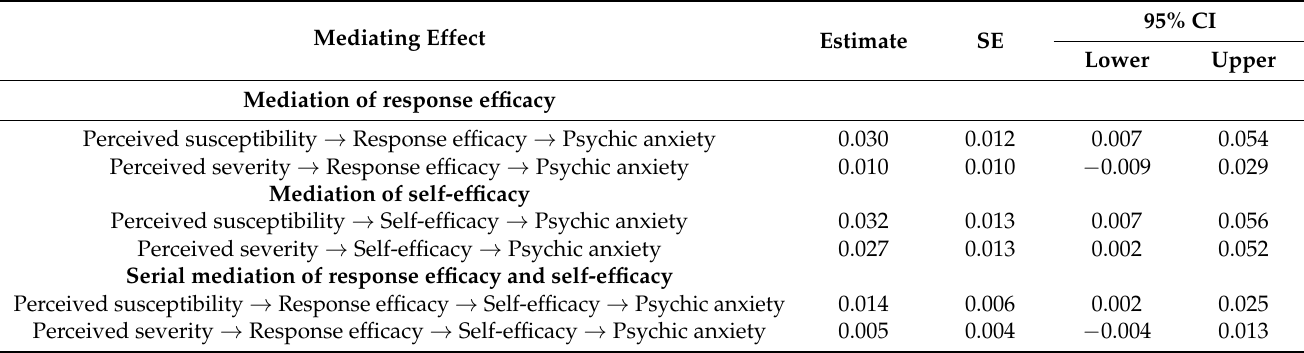
Table 3. Results of the mediating